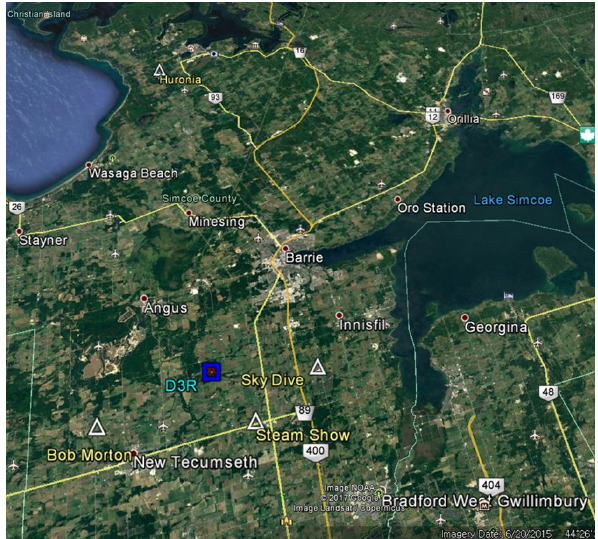
Figure 4. A map of the GCPEx field campaign. The five test sites are CARE, Sky Dive, Steam Show, Bob Morton, and Huronia. The ground observation instruments, namely 2DVD, D3R, and Pluvio, used in this research, were located at